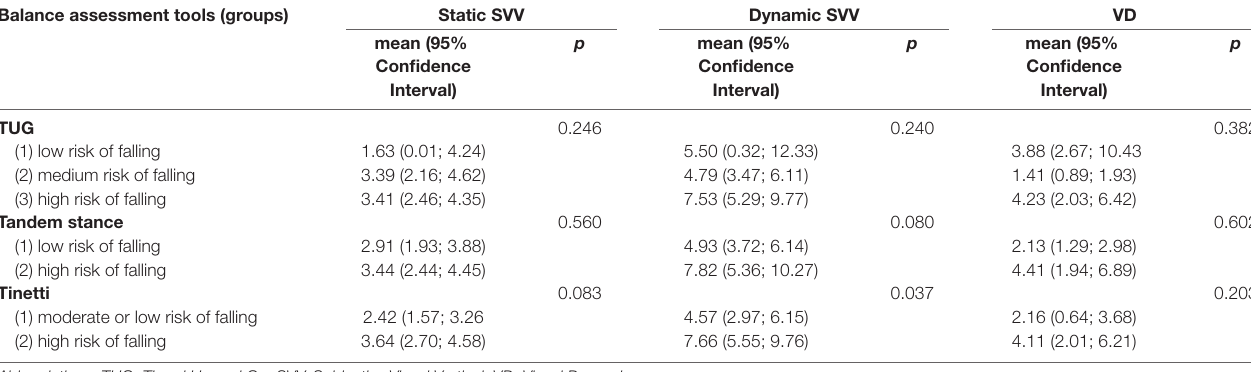
TABLE 3 | Comparison of static SVV, dynamic SVV, and VD with balance assessment results. Balance assessment tools (groups)